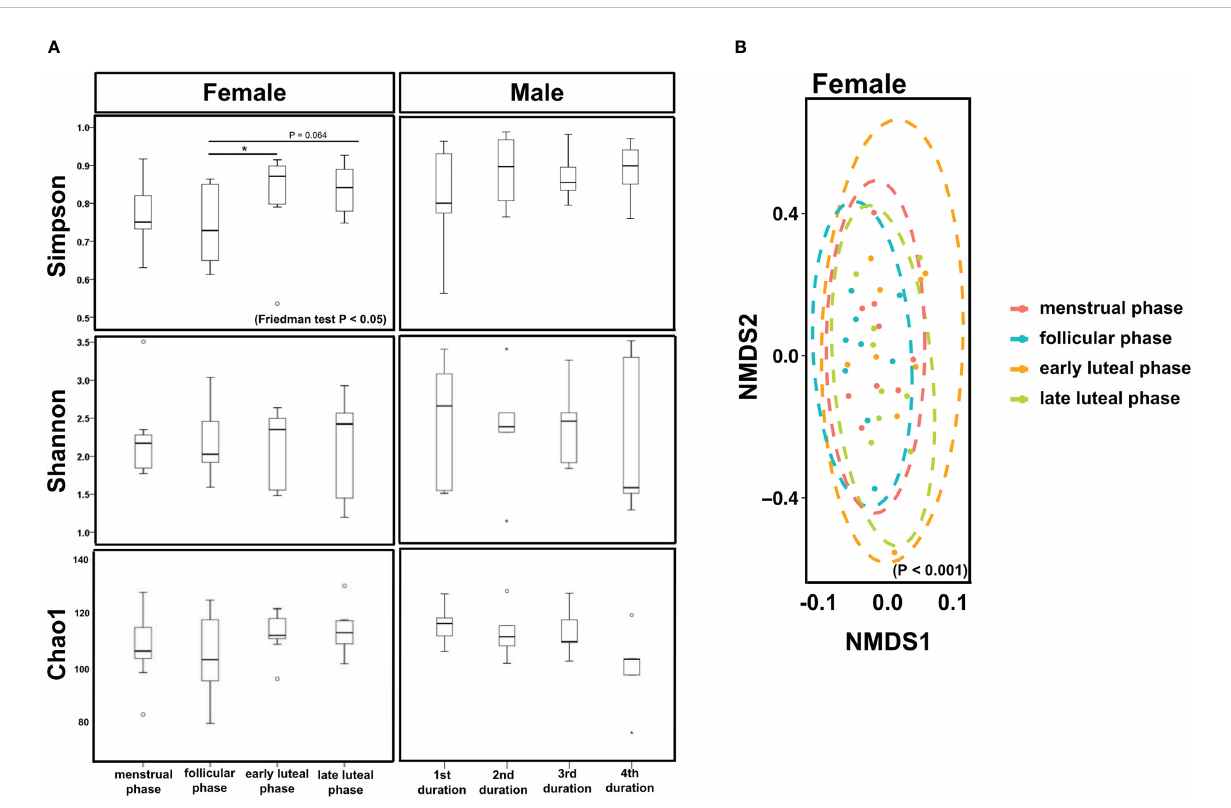
FIGURE 3 Bacterial diversity. (A) Box plots showing the alpha diversity indices, Simpson, Shannon, and Chao1, based on the phases of the menstrual cycles (menstrual, follicular, early luteal, and late luteal phases) or durations (days 1 – 2, 1 st duration; day 14, 2 nd duration; days 21 – 22, 3 rd duration; day 28, 4 th duration). Friedman test and Bonferroni test, * P < 0.05. Females, N = 9; Males, N = 5. (B) Nonmetric multidimensional scaling plot showing the dissimilarities of all samples collected in this study according to menstrual cycles (menstrual, follicular, early luteal, and late luteal phases). Ellipsoids represent a 95% con fi dence interval used to group each sample.